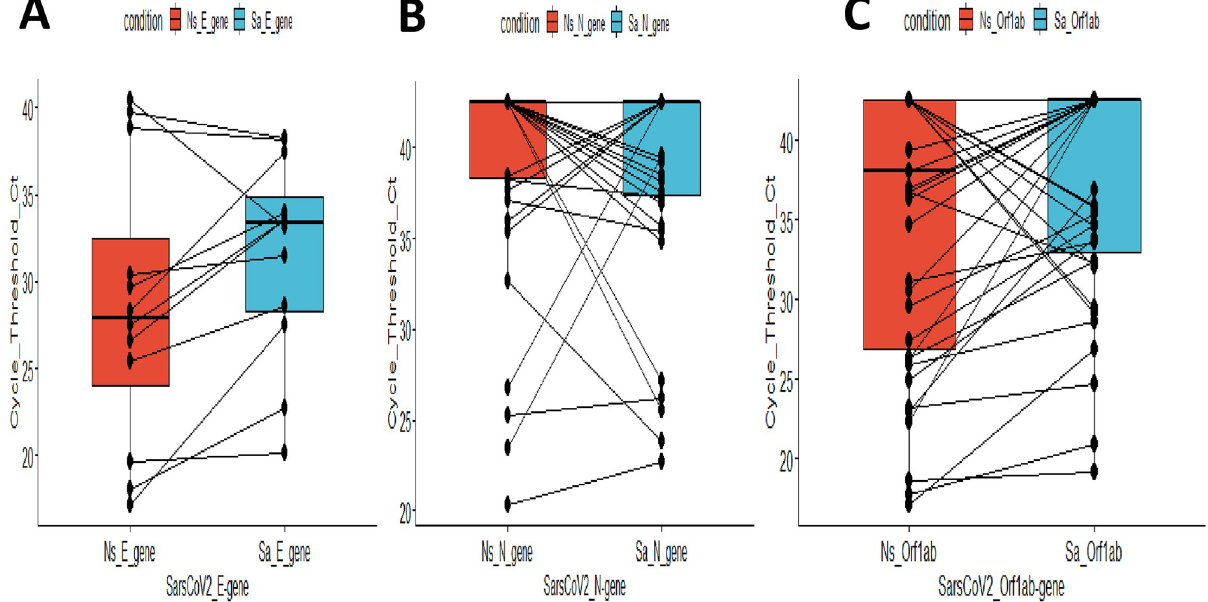
The percentage of positive and negative agreement of the saliva samples as compared with the nasopharyngeal swab were 67% and 97% respectively. The positive and negative predictive